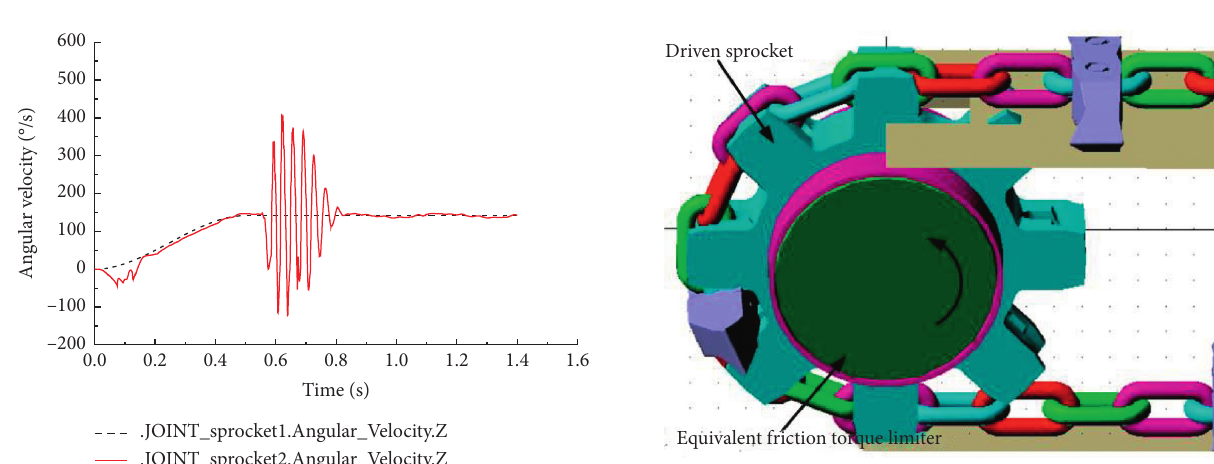
Figure 11: Friction torque limiter schematic diagram.